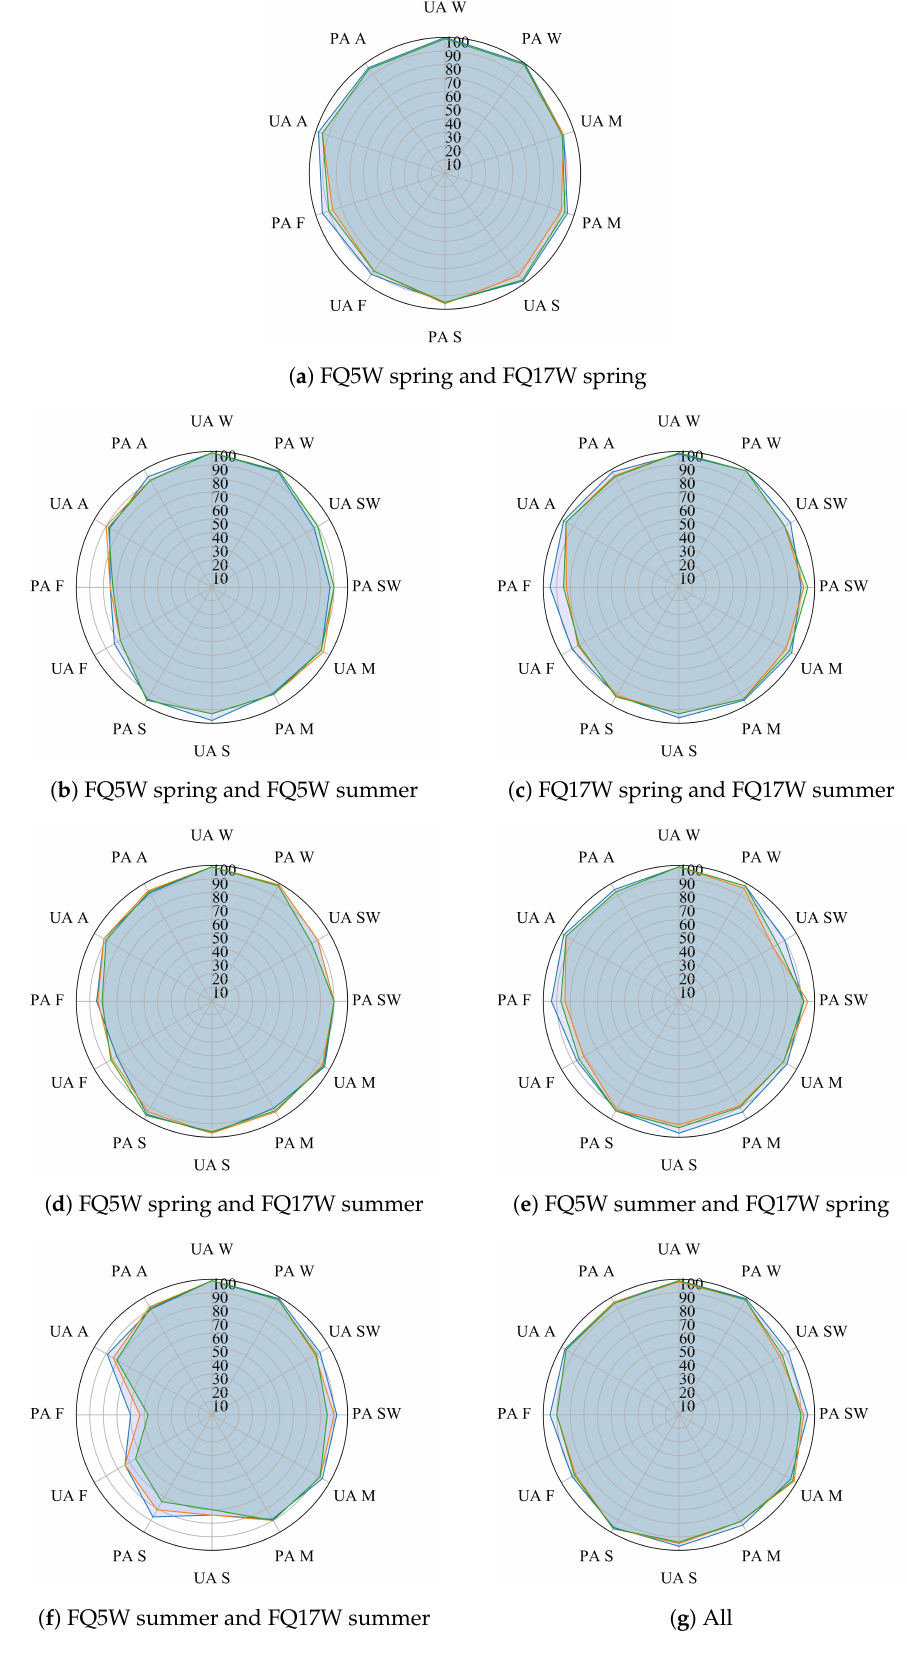
Figure 7. User’s (UA) and producer’s (PA) accuracies for water (W), shallow water (SW), marsh (M), swamp (S), forest (F), and agriculture/non-forested (A) for models based on multi-angle/temporal QP (blue), CP medium (orange), or CP high resolution (green) images and DEM and DSM